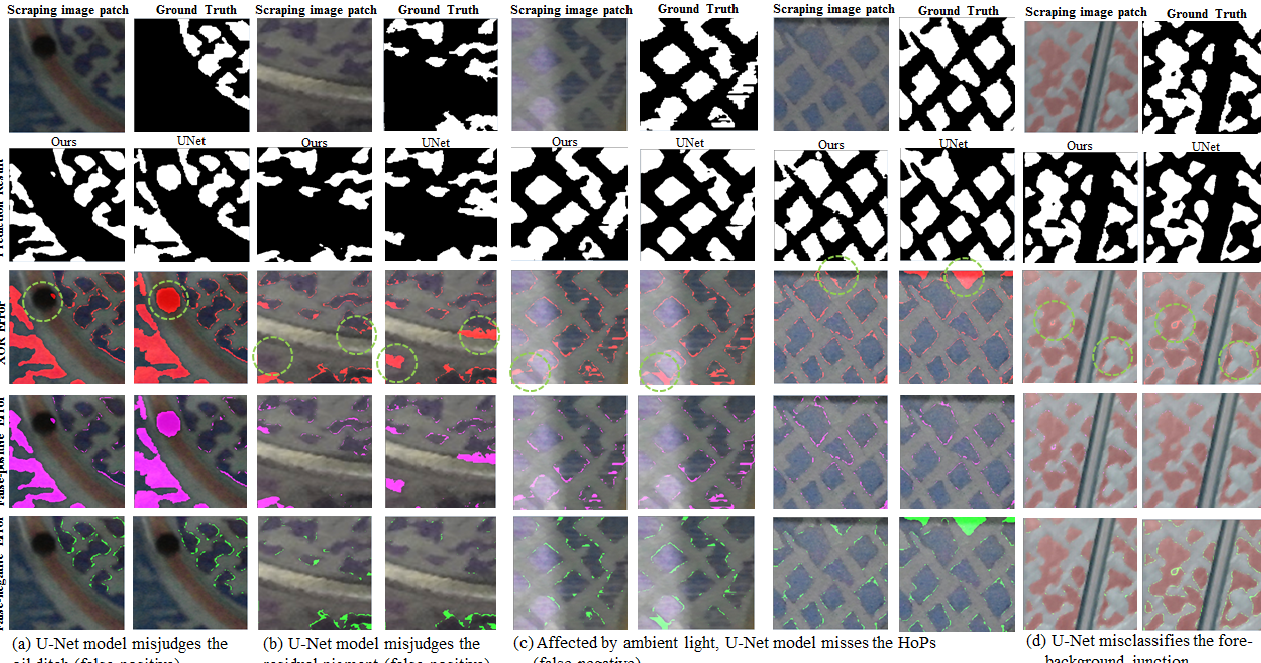
Figure 7. Three causes ( a – c ) of misjudgment on the U-Net model are oil ditch, residual pigment, and influence of ambient light, respectively. ( d ) Using a single classifier (U-Net) to classify fore- and background junction easily occurs the error (false positive/false negative).